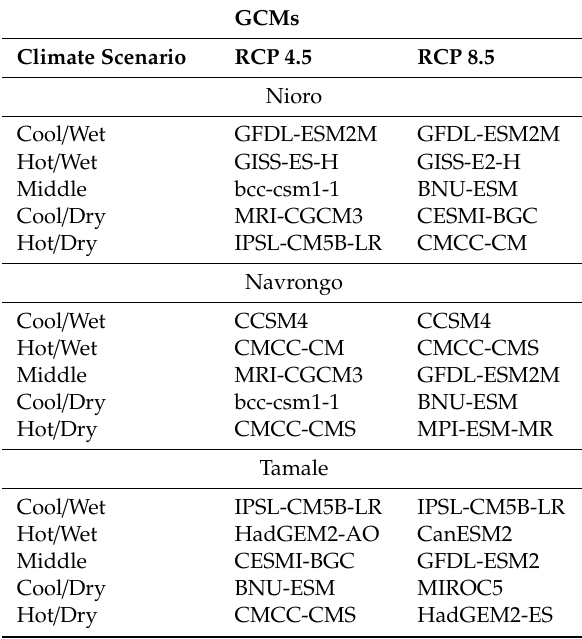
Table 4. General circulation models selected for each of the climate scenarios at the three study